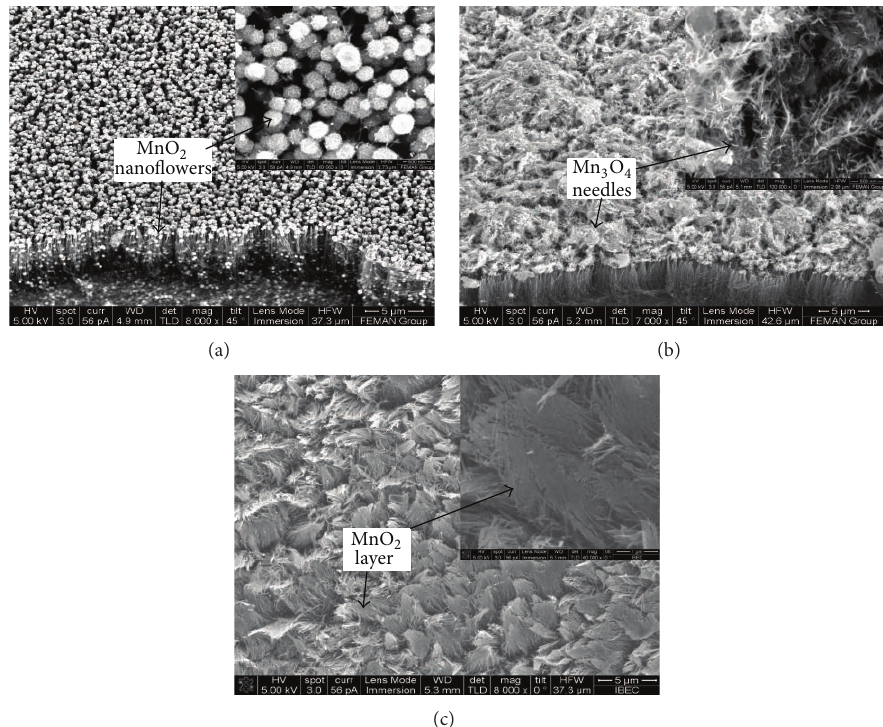
Figure 2: SEM images of wpCNTs/MnO 2 before electrochemical cycling (a), wpCNTs/MnO 2 after electrochemical cycling (0-1V) (b), and wpCNTs/MnO 2 after electrochemical cycling (0.1–0.8 V) (c). Inset graphs show top view of the CNTs